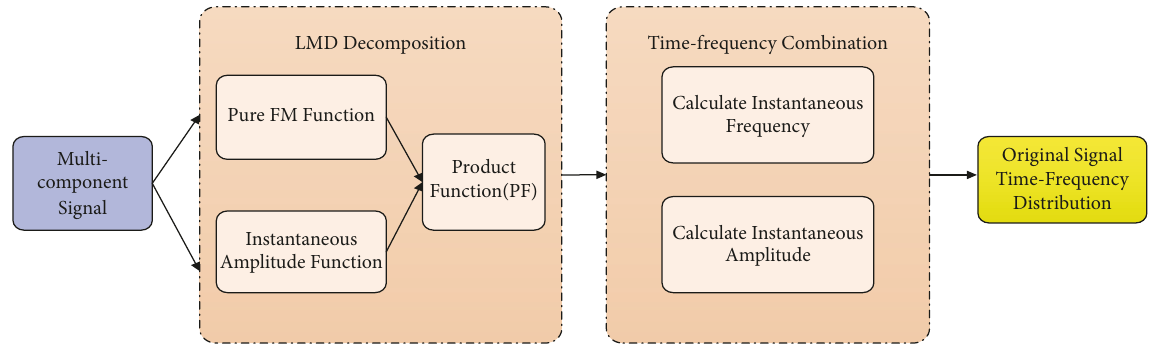
Figure 1: Schematic of local mean